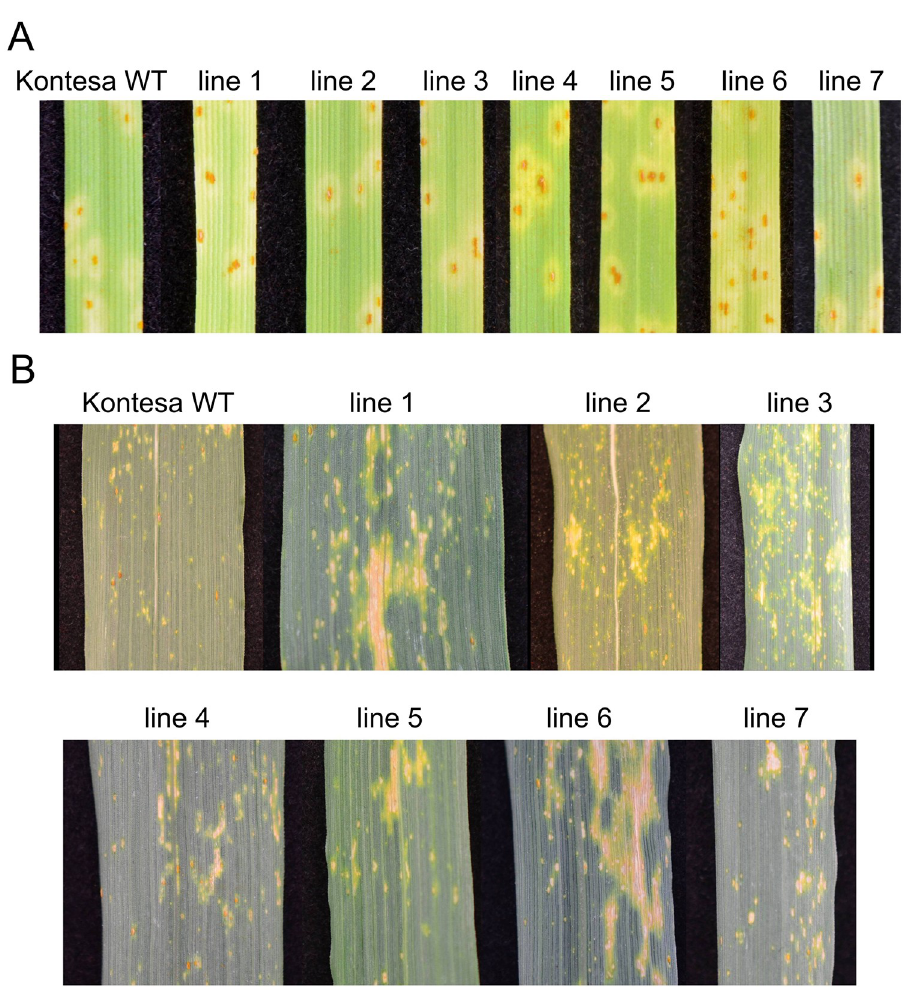
Fig 3. Infection symptoms on leaves of non-transgenic Kontesa and 7 transgenic lines overexpressing TaWAK6 inoculated with single spore isolate of P . triticina . A—Seedling leaves 10 day post-inoculation (dpi). B—Adult plant, flag leaves, 16